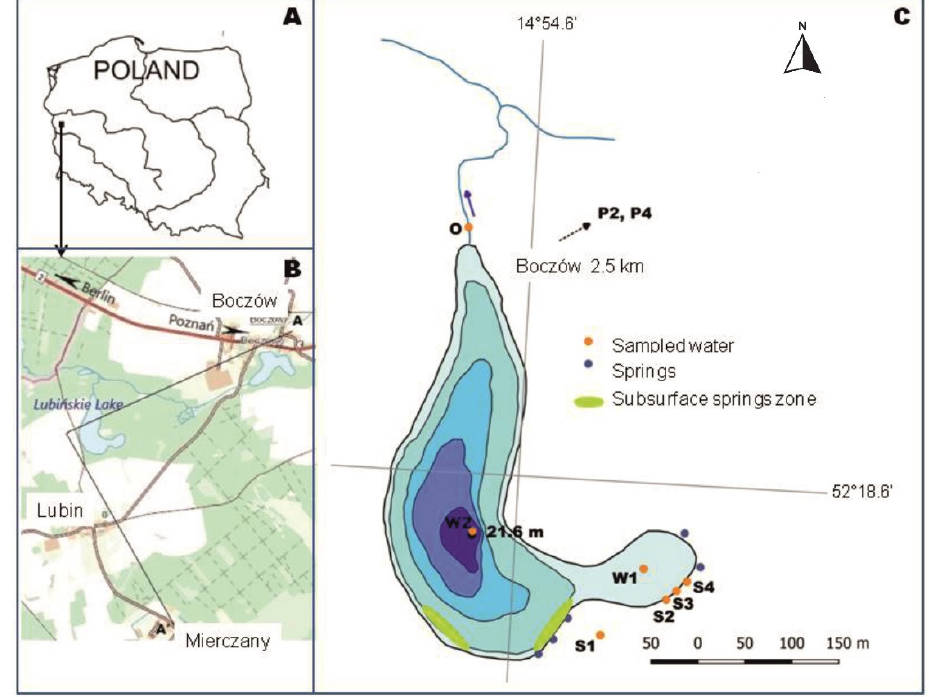
Figure 1. Location of Lubi ń skie Lake and the points of water samples intake from: The lake (W1 and W2), outflow (O), springs (S1–S4), and wells P2 and P4 ( A , C ). The line A–A’ shows the line of hydrogeological cross-section ( B ). Table 1. Parameters and morphometric indices of Lubi ń skie Lake (according to Ja ń czak [47]).